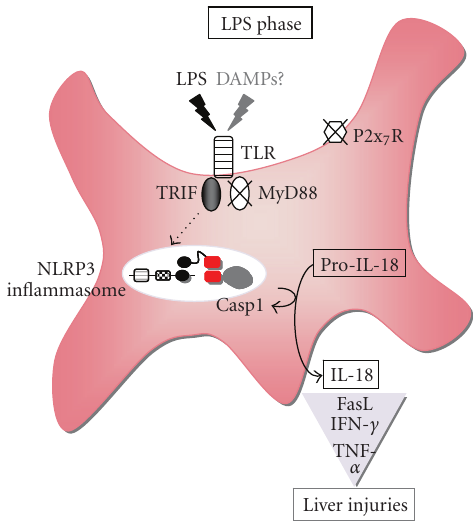
Figure 7: Molecular and cellular mechanisms for LPS phase. After challenge of P. acnes -primed wild-type mice with LPS, TLR4 is activated via TRIF for activation of NLRP3 inflammasome, which eventually leads to cleavage of procaspase-1 into its active form caspase-1. Active caspase-1, then, processes pro-IL-18 into active IL-18 for extracellular release. IL-18 upregulates both hepatotoxic Fas ligand (FasL) expression and TNF- α production. DAMPs and alarmin released from the injured hepatocytes might further activate the Kup ff er cells, eventually resulting in the acceleration of inflammatory responses. DAMPs, damage-associated molecular